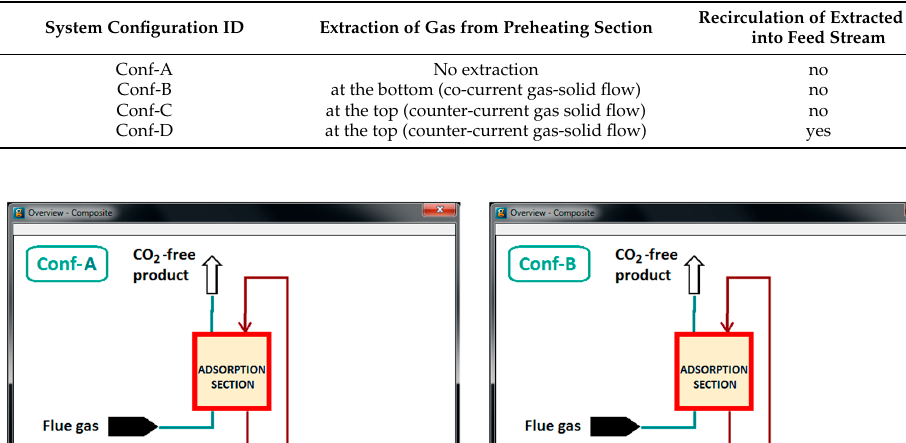
Table 3. List of implemented configurations of the MBTSA system.